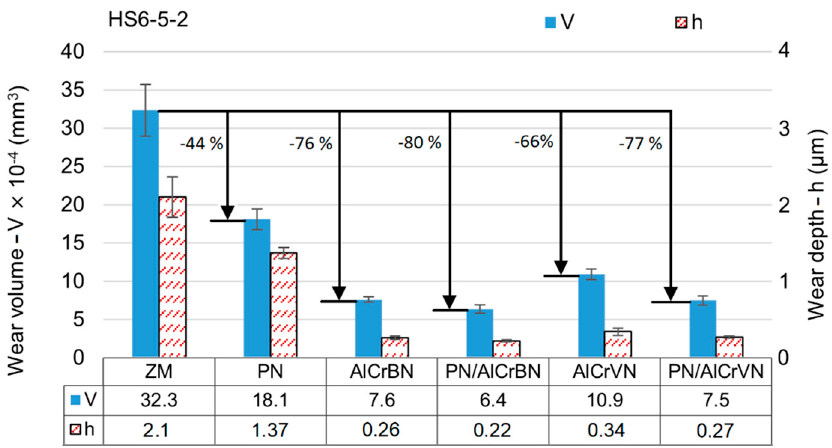
Figure 17. Wear volumes and wear depth of the tested materials of steel HS6-5-2.